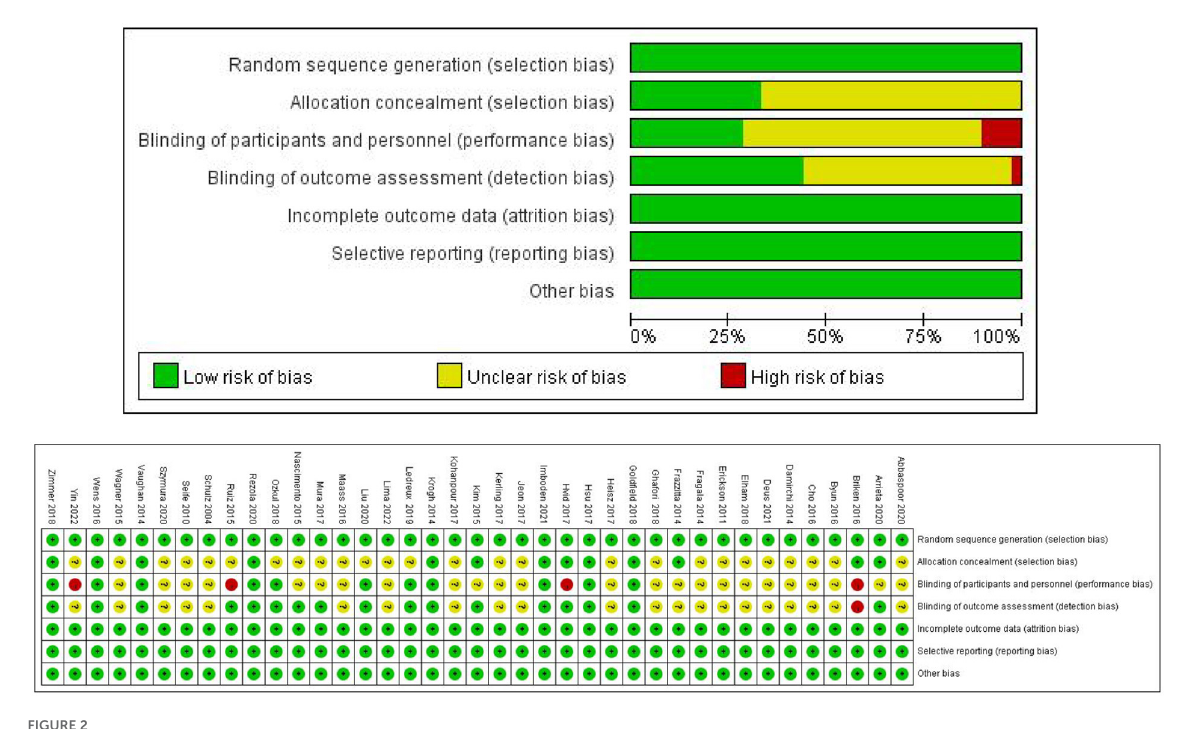
FIGURE2 Risk of bias assessment diagram.